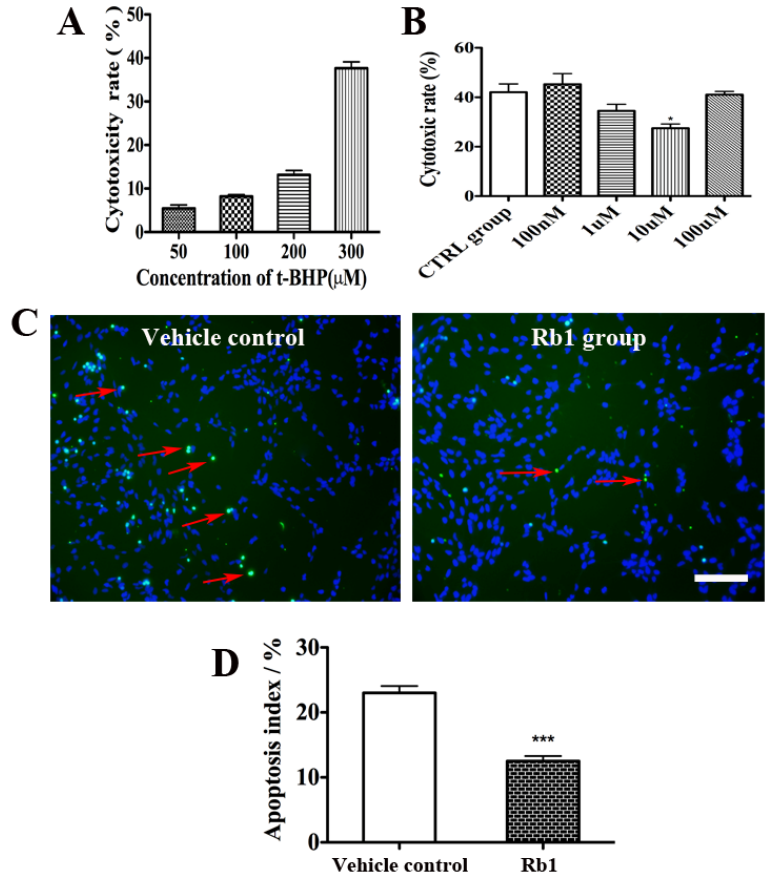
Figure 2. Rb1 pretreatment reduced oxidative stress on culture NPCs. ( A ) LDH assays revealed that t -BHP treatment has caused cell toxicity in a concentration-dependent manner; ( B ) LDH assays revealed that the pretreatment of 10 µM Rb1 for 24 h significantly attenuated t -BHP-induced cell injury compared with vehicle controls. Results are expressed mean ± SEM, n = 4, * p < 0.05 versus control group; ( C ) Representative photomicrographs of the TUNEL assay. The red arrow indicates apoptotic cells; ( D ) The percentage of TUNEL-positive cells was significantly reduced in Rb1-treated group compared with that in the vehicle-treated group. Eight representative fields per well and three wells per experiment were counted. Data were presented as means±SEM from six experiments. * p < 0.01 compared with the control group. Scale bar: 75